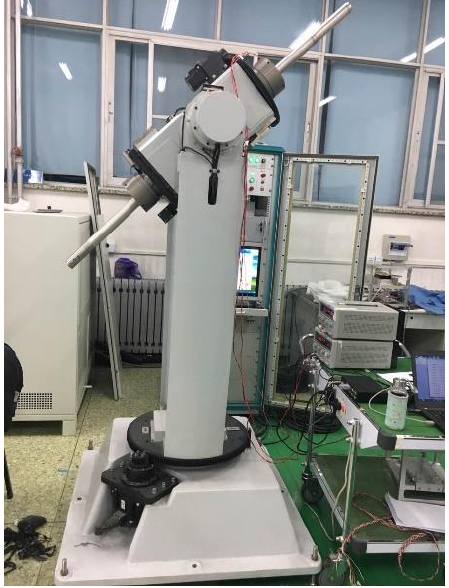
Figure 10. The residual error after each iteration of the scale factor error ACCs.